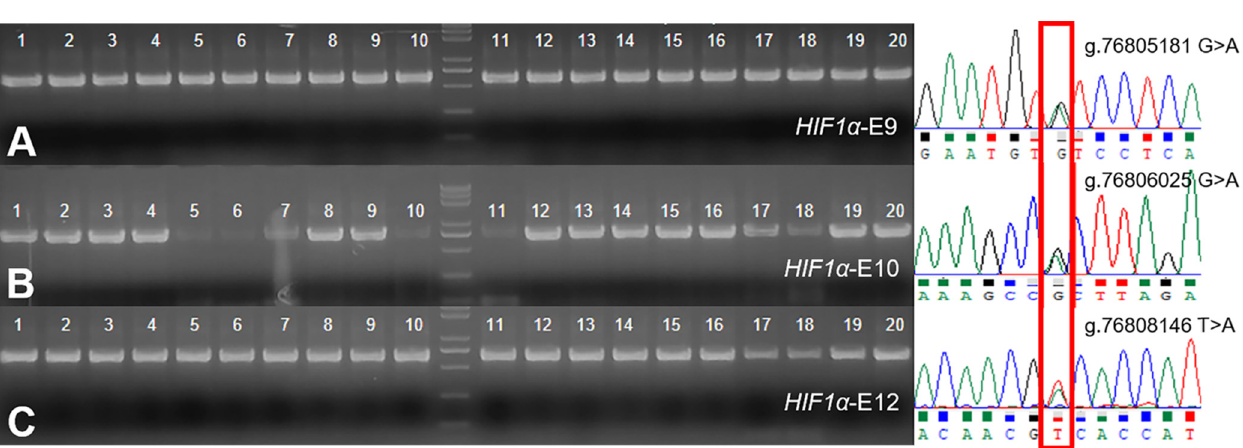
Figure 1. Differences in blood gas indicators between Tibetan sheep, Hu sheep and Gansu alpine merino sheep. Partial pressure of carbon dioxide (pCO 2 ) and partial pressure of oxygen (pO 2 ) ( A ), oxygen saturation (sO 2 ) and hematocrit (Hct) ( B ), hemoglobin (Hb) concentration ( C ), half-saturation oxygen partial pressure (p50) ( D ), total carbon dioxide (tCO 2 ) and glucose (Glu) concentration ( E ) are shown. * Indicates significant ( p < 0.05) and ** indicates extremely significant ( p < 0.01) differenced.